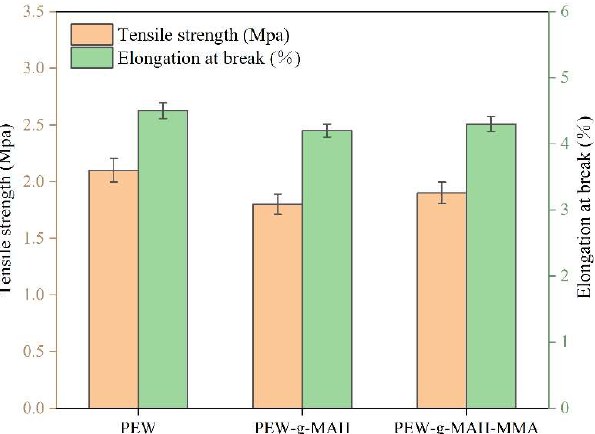
Figure 5. Tensile strength and elongation at break of PEW, PEW- g -MAH, and PEW- g -MAH-MMA.